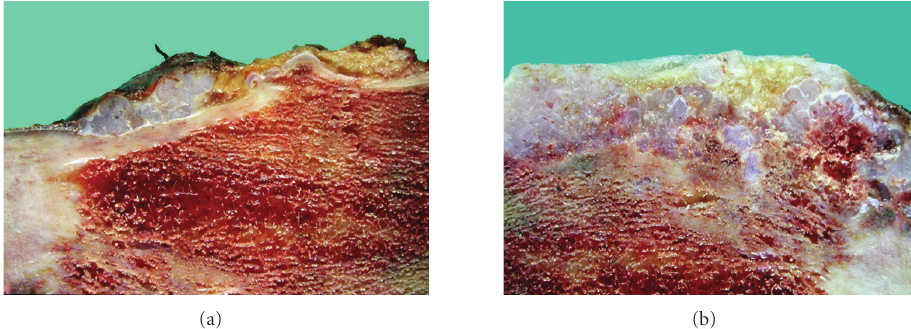
Figure 3: (a) Gross tumor specimen revealing cartilage overlying cortex of the ilium. (b)Gross tumor specimen revealing cortical invasion by cartilage.